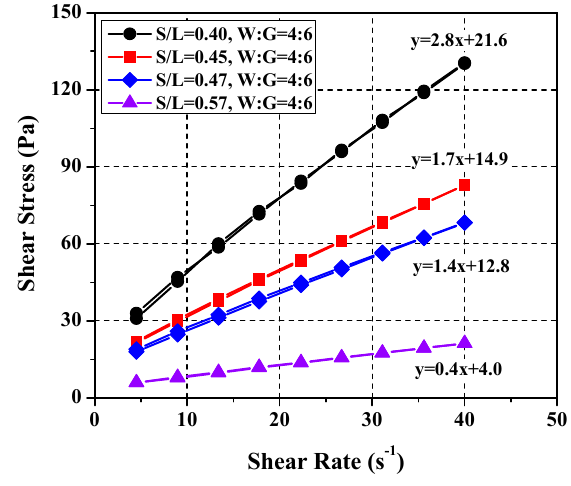
Figure 7. Variation of rheology depending on limestone ratios.